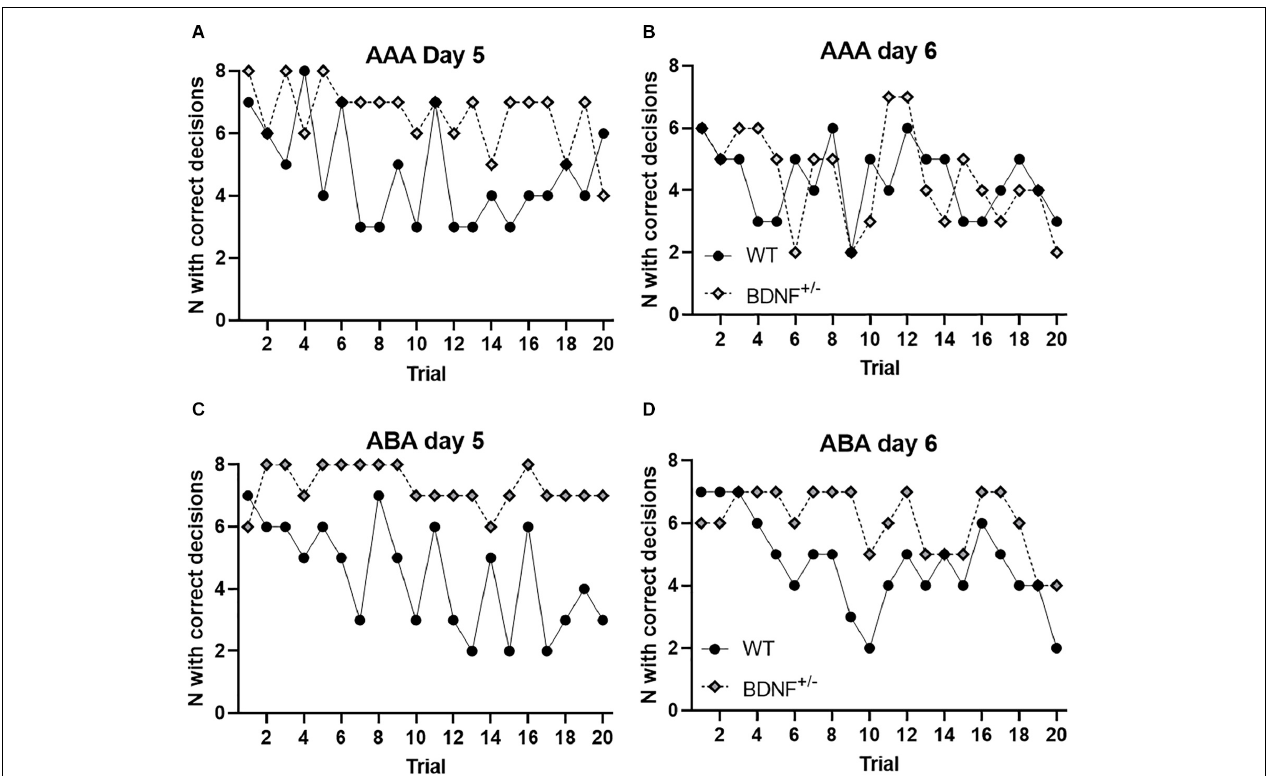
FIGURE 4 | Comparison of trial-by-trial learning on days 5 and 6. To assess trial-by-trial learning, the number of correct arm choices made by each animal was plotted for each individual trial. (A) The number of animals entering the correct arm in context “A” on Day 5, consistently declined over the 20 trial period with regard to wild-type animals. By contrast, BDNF + / − mice numbers remained consistently high. (B) The number of animals entering the correct arm in context “A” on Day 6 is equivalent in wild-type and BDNF + / − mice. (C) When extinction learning is tested in context “B”, wild-type animals exhibit a rapid diminishment of choice behavior for the previously rewarded arm, whereas BDNF + / − mice persist in entering the arm. (D) On day 6, animals were returned to the “A” context (in the absence of a reward). Here, WT animals show an increase of “correct” arm choices in the initial trials compatible with a renewal effect. This response then diminished corresponding to extinction learning as the animal understands that no reward will be made available. BDNF + / − mice show arm choice behavior that is similar to Day 5, but toward the end of the trial block evidence of extinction learning begins to